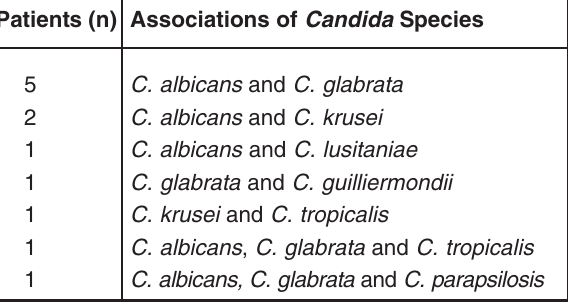
Patients (n) Associations of Candida Species